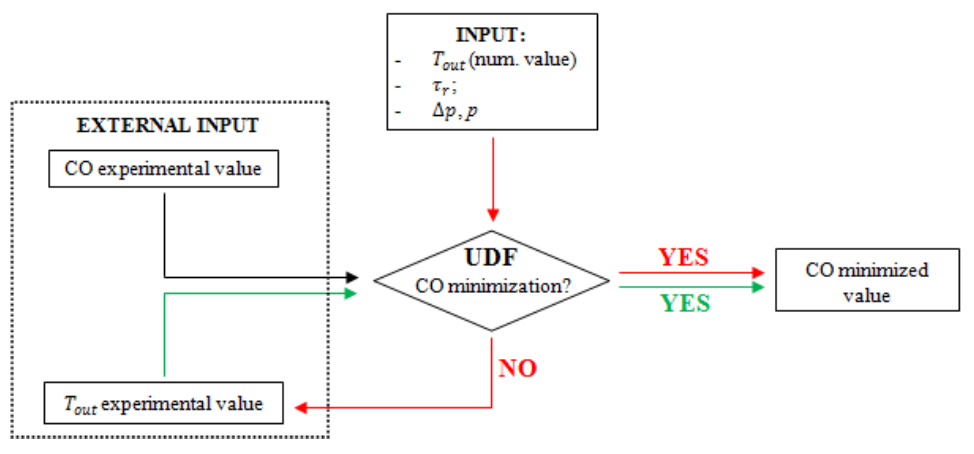
Figure 15. UDF flow chart for the CO